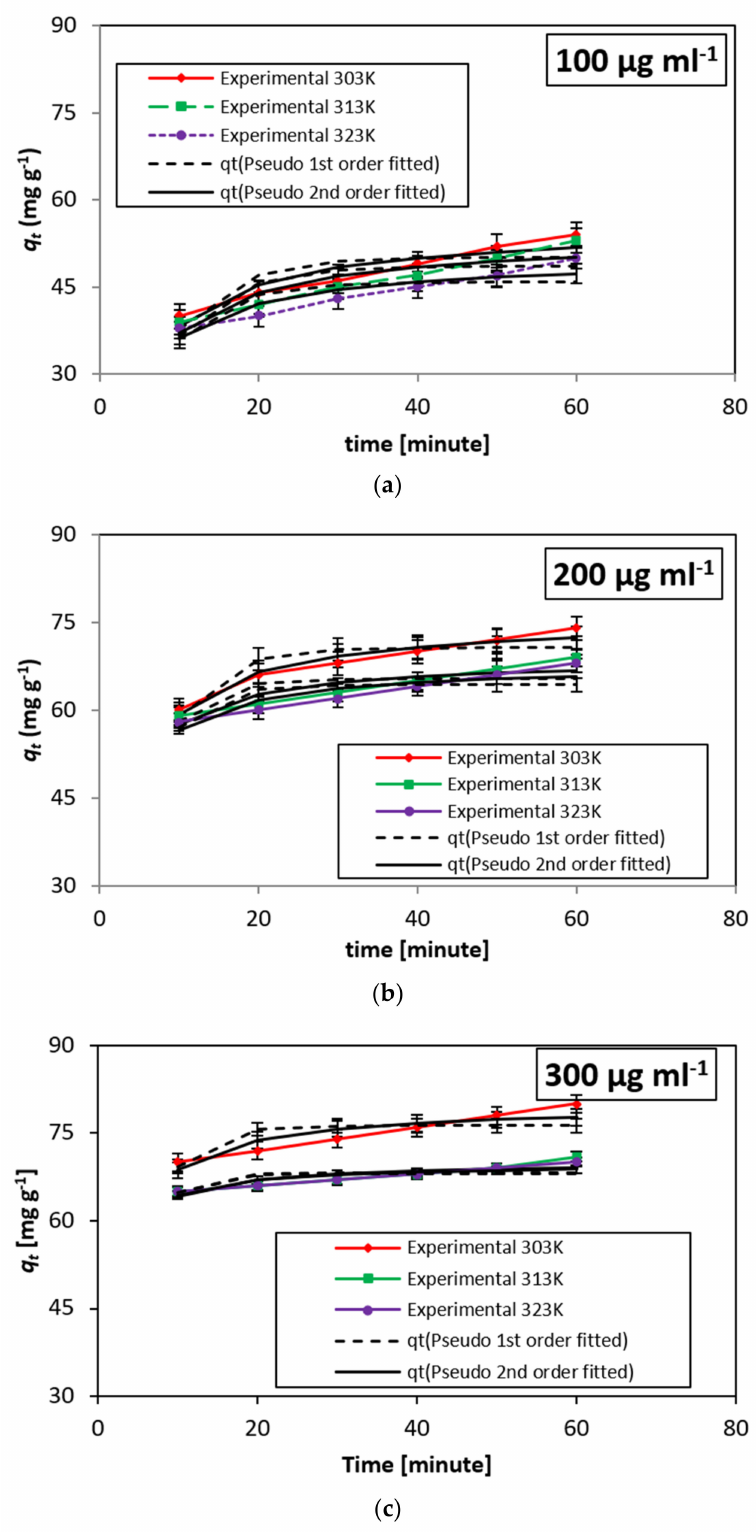
Figure 8. ( a – c ) Kinetic model developed for DB15 dye on HNT system at different temperatures. Examination of the kinetics data (Figure 8) represents raise in adsorption with an increase in adsorbent concentration. Similarly, the adsorption rate increases with time. However, it is realized that the rate of adsorption decreases as the temperature